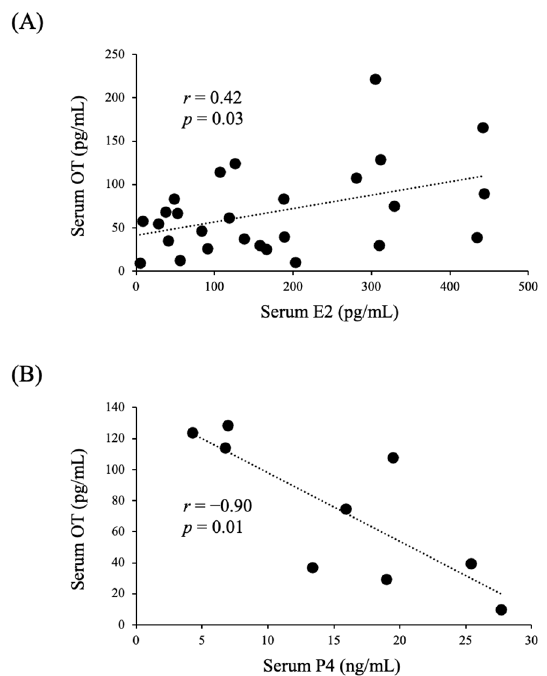
Figure 2. Correlations between serum OT and serum E2 ( A ) or P4 ( B ) levels in women with regular menstrual cycles. menstrual